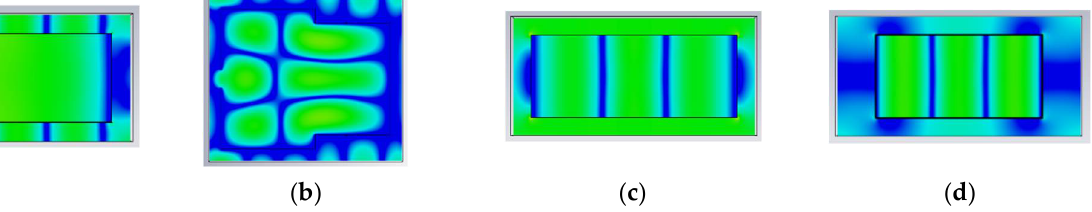
Figure 9. Mode303 field distribution of inductive step. ( a ) x section, ( b ) y section, ( c ) z section of the front part, and ( d ) z section of the back part.